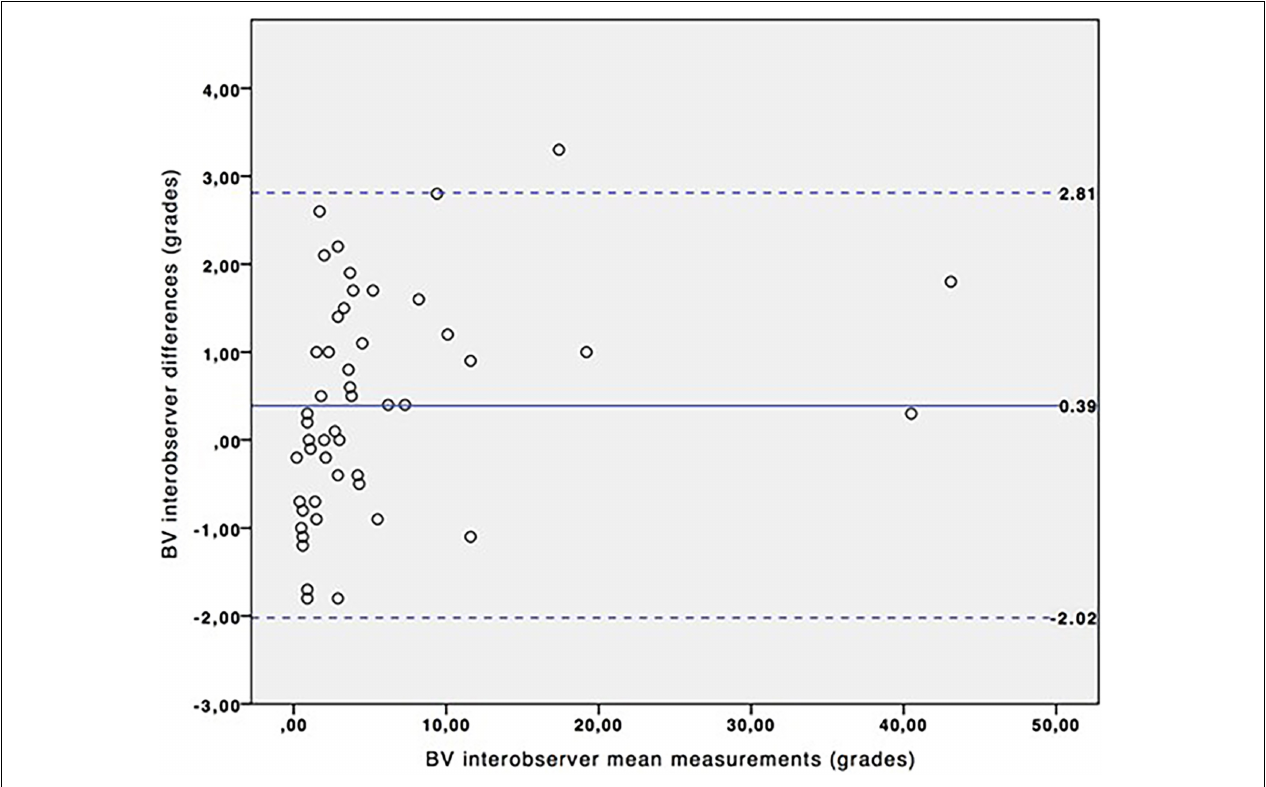
FIGURE 2 | Interobserver variation for BV angle measurements. Bland-Altman plot for BV angle. Continuous blue line represents the mean of the interobserver differences and the dashed lines represent the 95% confidence interval.